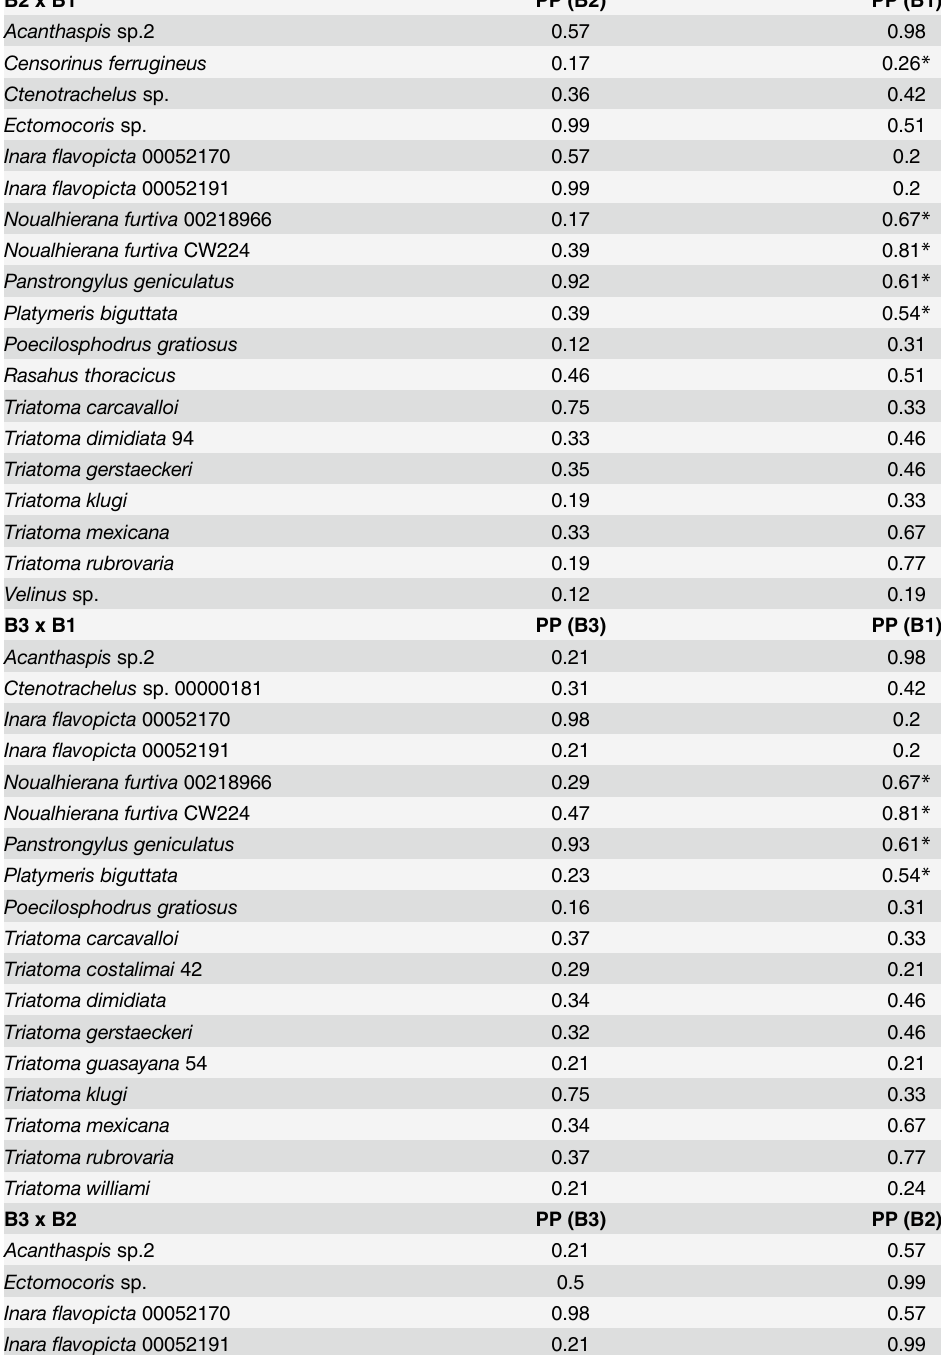
Table 2. Taxa identified as divergent in each of the comparisons between topologies. Posterior proba- bilities (PP) and bootstrap (BP) values obtained for the clades in which the taxa were recovered are indicated. * indicates that the taxa did not share the MRCA with the other two closest species but still was recovered in the same clade, i . e ., closely related to the same set of species. — indicates that the clade was not recovered in the given phylogeny. ML (maximum likelihood phylogeny), B1 (Bayesian inference with one calibration point), B2 (Bayesian inference with six calibration points), B3 (Bayesian inference with seven calibration